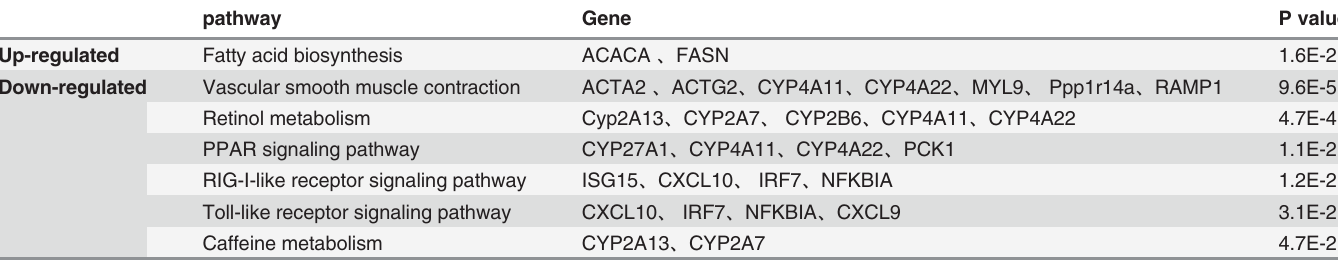
BH: Songliao Black pigs with higher backfat of live group BL:Songliao Black pigs with lower backfat of live